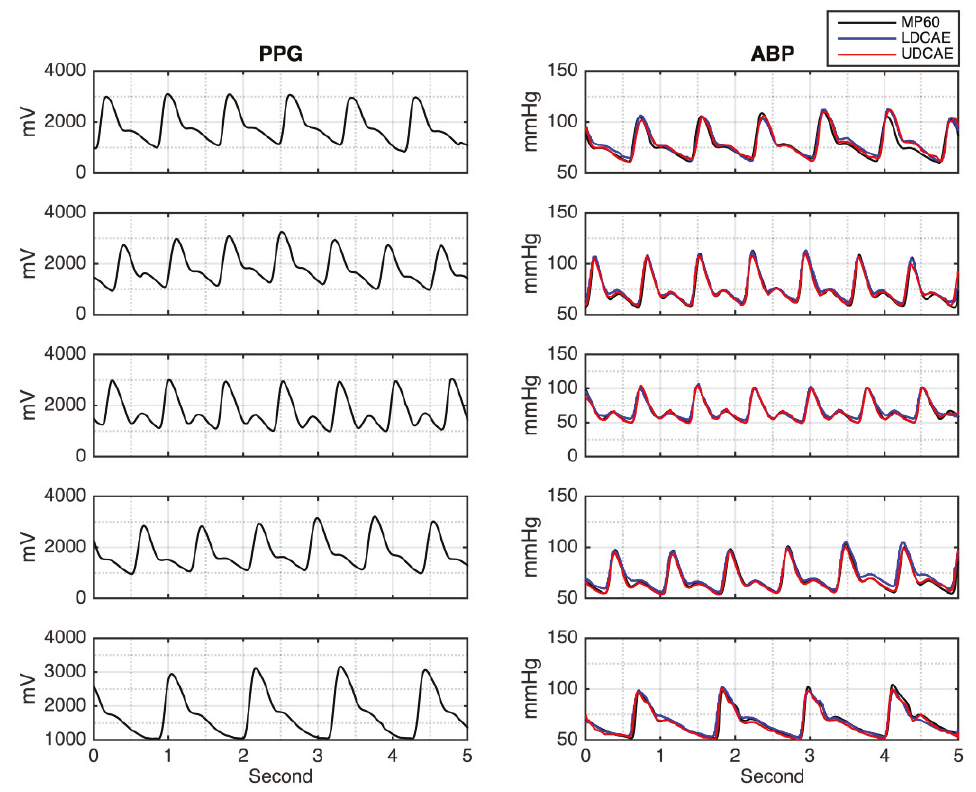
Figure 2. The photoplethysmography (PPG) input signal and arterial blood pressure (ABP) results between LDCAE and UDCAE models in comparison to MP60 IntelliVue Patient Monitor.